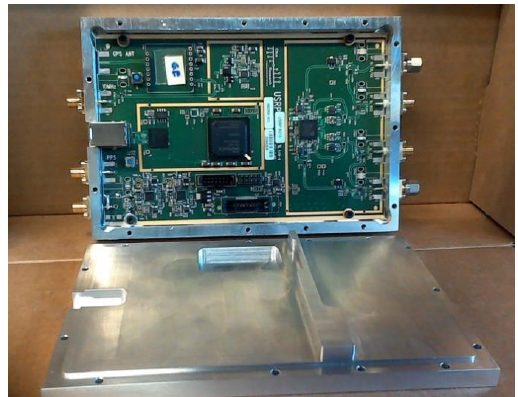
Figure 3. Photograph of the B210 USRP circuit board mounted inside its custom shielded housing and associated cover, which exhibits a central ridge that isolates RF fields from the digital portion of the circuitry.